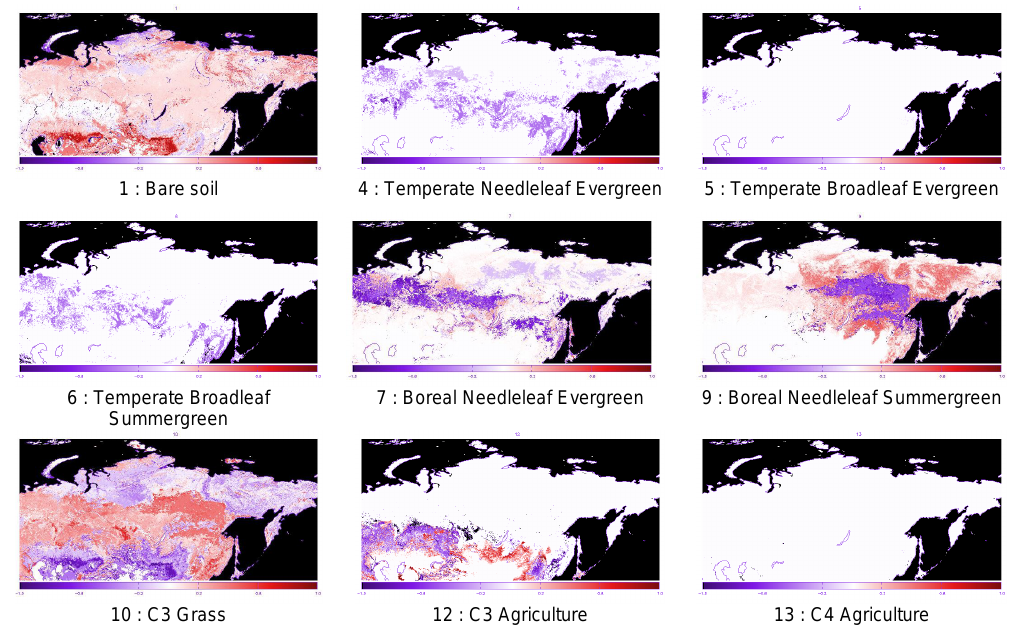
Figure 7. Di ff erence (new − standard) PFT maps. The percentage di ff erences are represented in color scale, ranging from − 1 (blue) to + 1 (red).